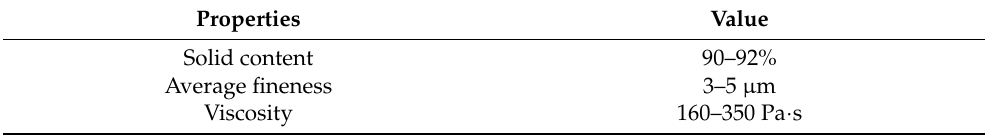
Table 1. Physical and chemical properties of the silver paste.